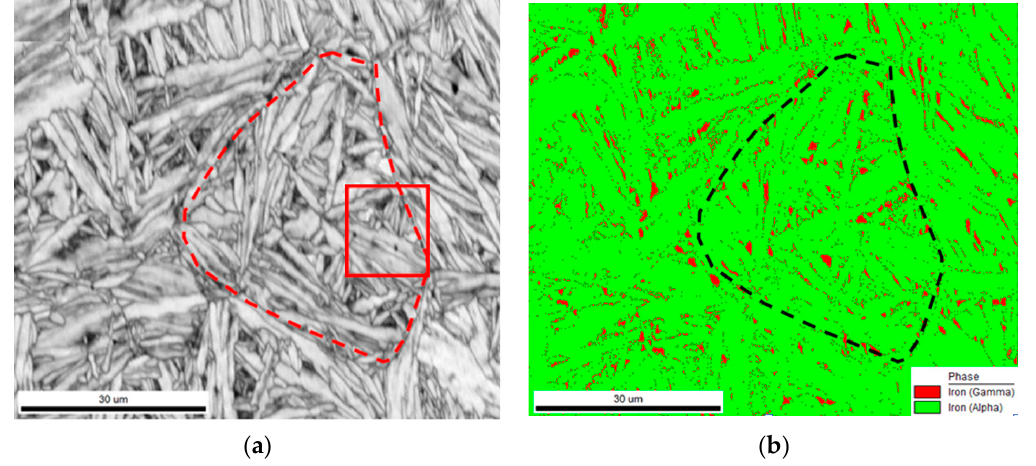
Figure 7. EBSD maps of AT specimen: ( a ) IQ map and ( b ) phase map. The dashed line indicates prior austenite grain boundary (PAGB).